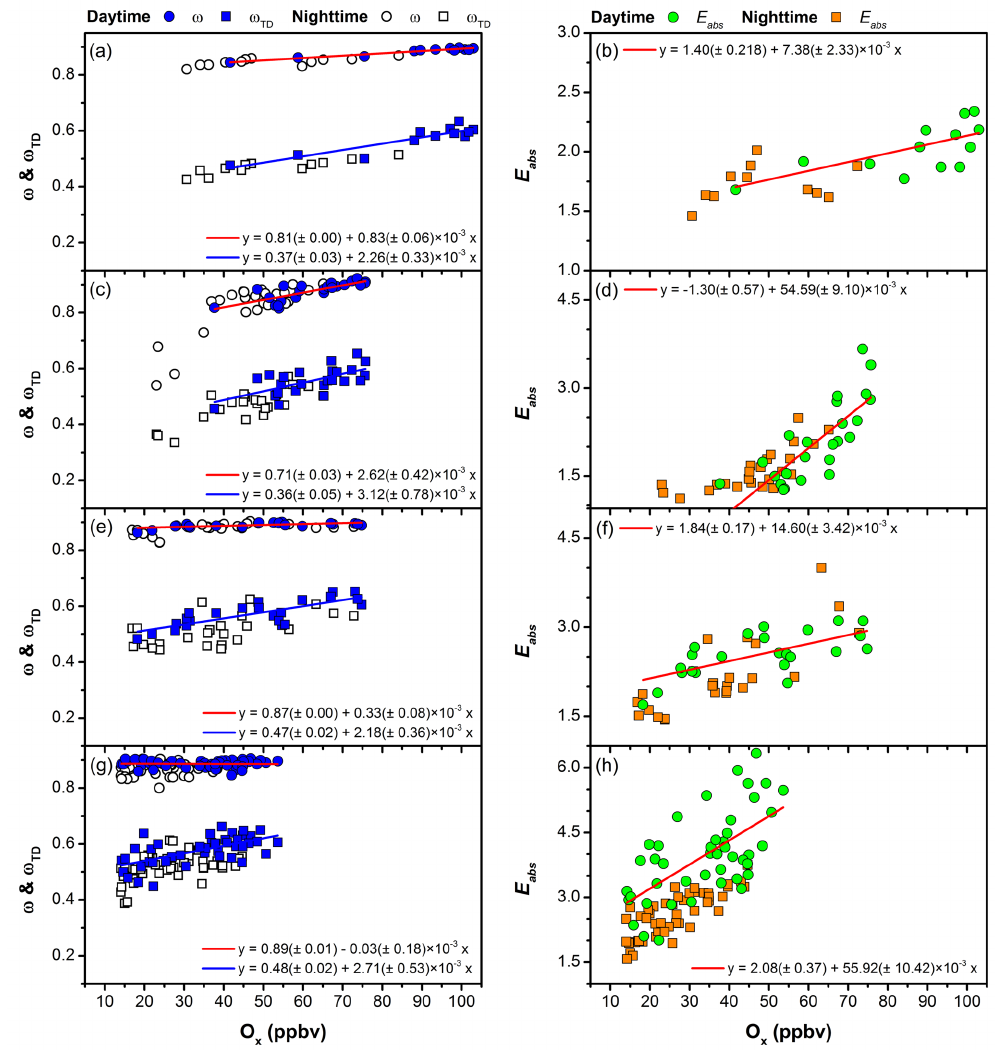
Figure 7. Four selected case studies of the variations in hourly-averaged ω , ω TD , and E abs as a function of hourly-averaged O x concentra- tions. (a, b) Case 1: on 16 June 2016; winds were typically from the north. (c, d) Case 2: 25 to 26 June 2016, wind direction varied from north to south. (e, f) Case 3: 7 to 8 July 2016; winds were mainly from the southeast. (g, h) Case 4: 9 to 12 July 2016; winds were mainly from the northeast. The daytime (from 06:30 to 18:30 local time) and nighttime (from 18:30 to 06:30 local time) data have been marked in different colours and symbols. The slope of the linear regression (red and blue lines, only for daytime data) is representative of the oxidation rate of each parameter (the fit standard error is shown in